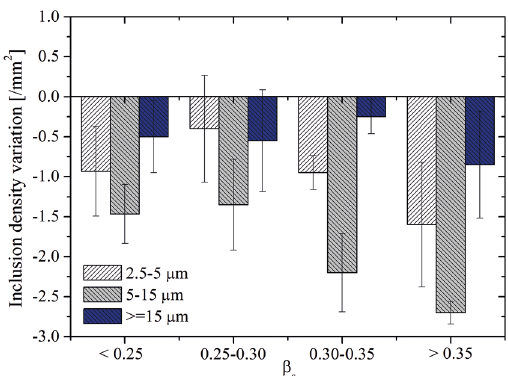
(kinetic Figure 10. Change in inclusion density as a function of β s parameter). phenomenon and new inclusions could be generated. It is possible to obtain new inclusions or "return" inclusions in the liquid steel, such as reoxidation, cleaning of the slag/ steel interface with particles trapping inside the steel and erosion of the refractory ladle wall 41 . For inclusions of the diameter range ≥ 15 µm, a dependence of the inclusionary cleanliness with the parameter β is not clearly observed, s which verifies the smaller values related to the variation of inclusion density, for the greatest diameter range. The kinetic parameter of stirring can also be related to the desulphurization, i.e. removal of S from the liquid steel, being a good indicator of the slag/steel interaction. Figure 11 shows the variation of the S content in the liquid steel as a function of the kinetic parameter, β . s